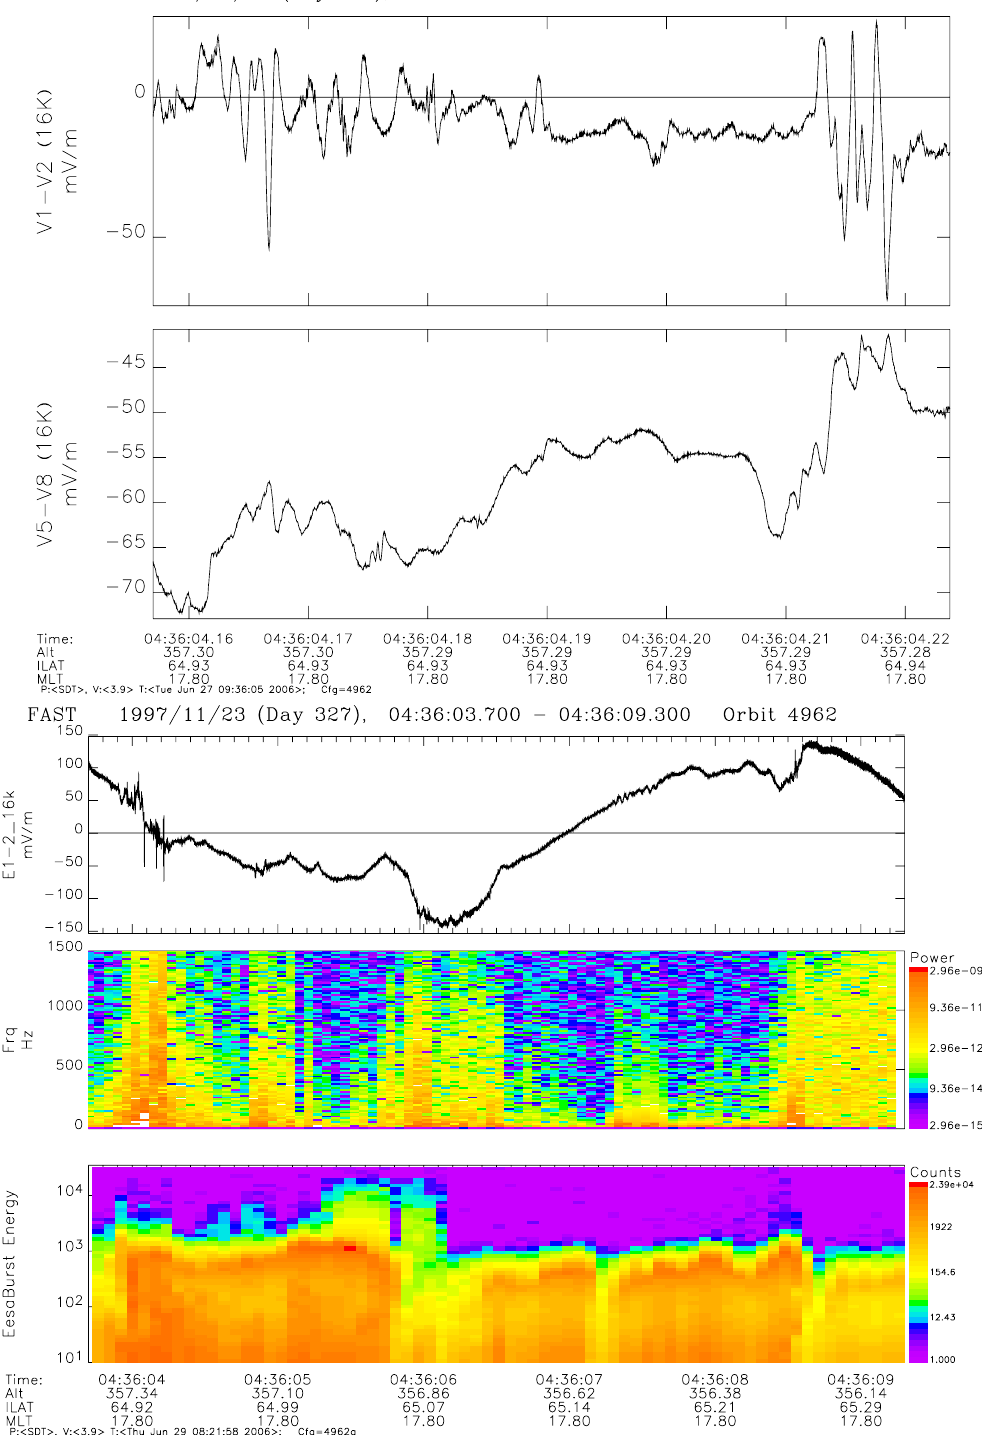
Fig. 1. Top two panels: FAST observations of EIC-like electric fields. The upper panel shows the V1-2 signal collected with a 5m boom with a 2.5m projection transverse to the magnetic field lines. The lower panel shows the V5-8 signal collected with a 56m boom with a 48m transverse projection. The booms are on the spin plane and the spacecraft is in a cartwheel configuration. Bottom three panels: the oscillations in a broader context, V1-2 signal (upper panel), electric field power spectrum (middle panel), and electron energy spectra (in eV) (lowest